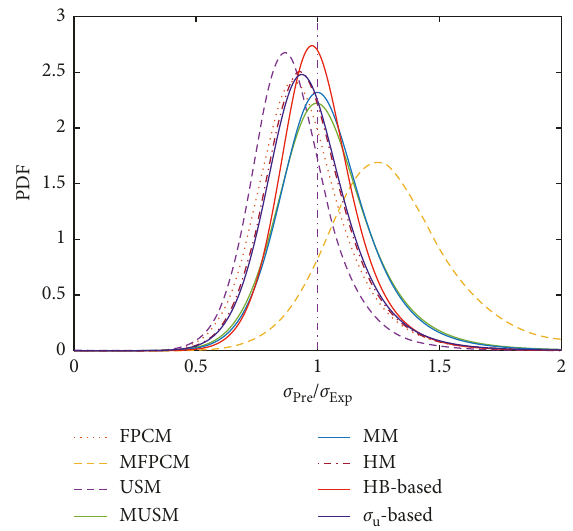
Figure 7: Probability density functions of the considered esti- mation